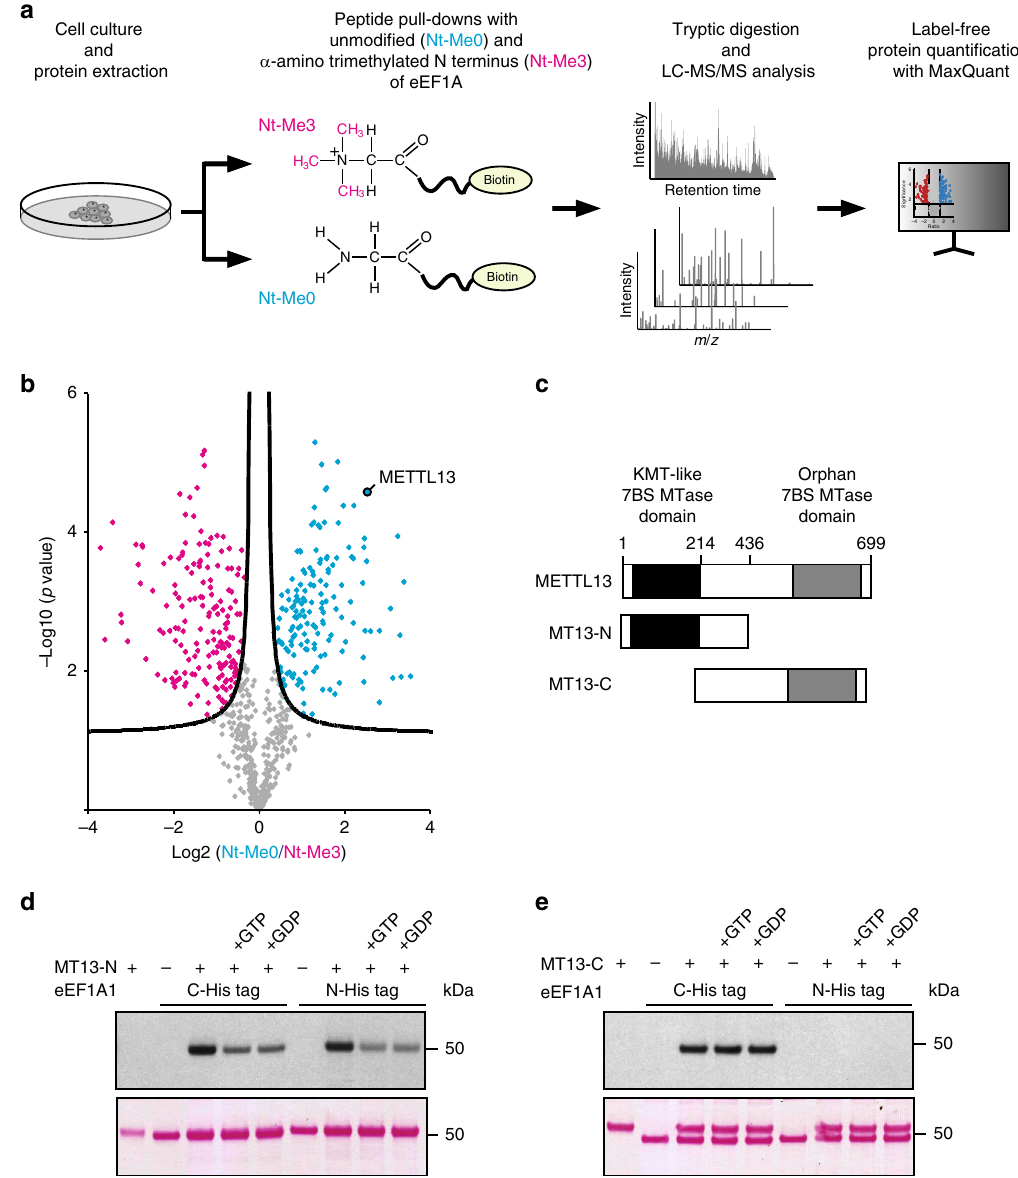
Fig. 1 Identi fi cation of METTL13 as an eEF1A-speci fi c methyltransferase. a Work fl ow of mass spectrometry-based quantitative peptide pull-down screen. Synthetic peptides corresponding N-terminally trimethylated (Nt-Me3) and unmethylated (Nt-Me0) eEF1A were used as baits to enrich proteins from HAP-1 cell extracts. b Volcano plot demonstrating enrichment of proteins by the unmodi fi ed (cyan circles) versus N-terminally trimethylated (magenta circles) bait peptides. The curved line represents the signi fi cance cutoff (FDR = 0.01 and s0 = 0.1). The putative methyltransferase METTL13 is indicated and all represented proteins are listed in Supplementary Data 1. c Domain organization of METTL13. The boundaries for used constructs encompassing the N-terminal (MT13-N) and the C-terminal (MT13-C) methyltransferase domains are indicated. d , e Evaluation of METTL13 constructs for eEF1A-speci fi c methyltransferase activity. MT13-N ( d ) and MT13-C ( e ) were incubated with [ 3 H]-AdoMet and eEF1A1 carrying an N-terminal or C-terminal His-tag in the absence of cofactors and in the presence of either GDP or GTP. Methylation was visualized by fl uorography (top panels) and the membranes were stained with Ponceau S (bottom panels) to assess protein